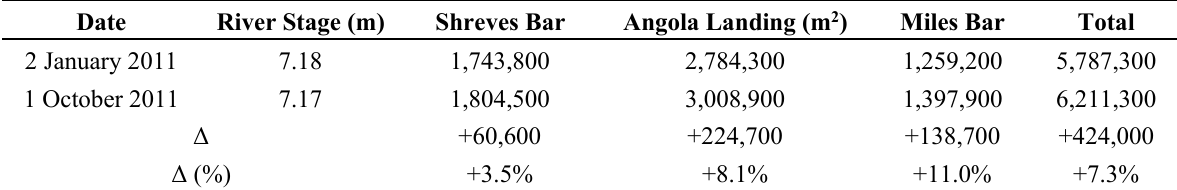
Figure 4. Changes in surface area of three large mid-channel bars near Tarbert Landing of the Mississippi River after the 2011 spring flood. Table 2. Changes ( Δ ) in surface area of three large channel bars near Tarbert Landing of the Mississippi River before and after the 2011 Spring